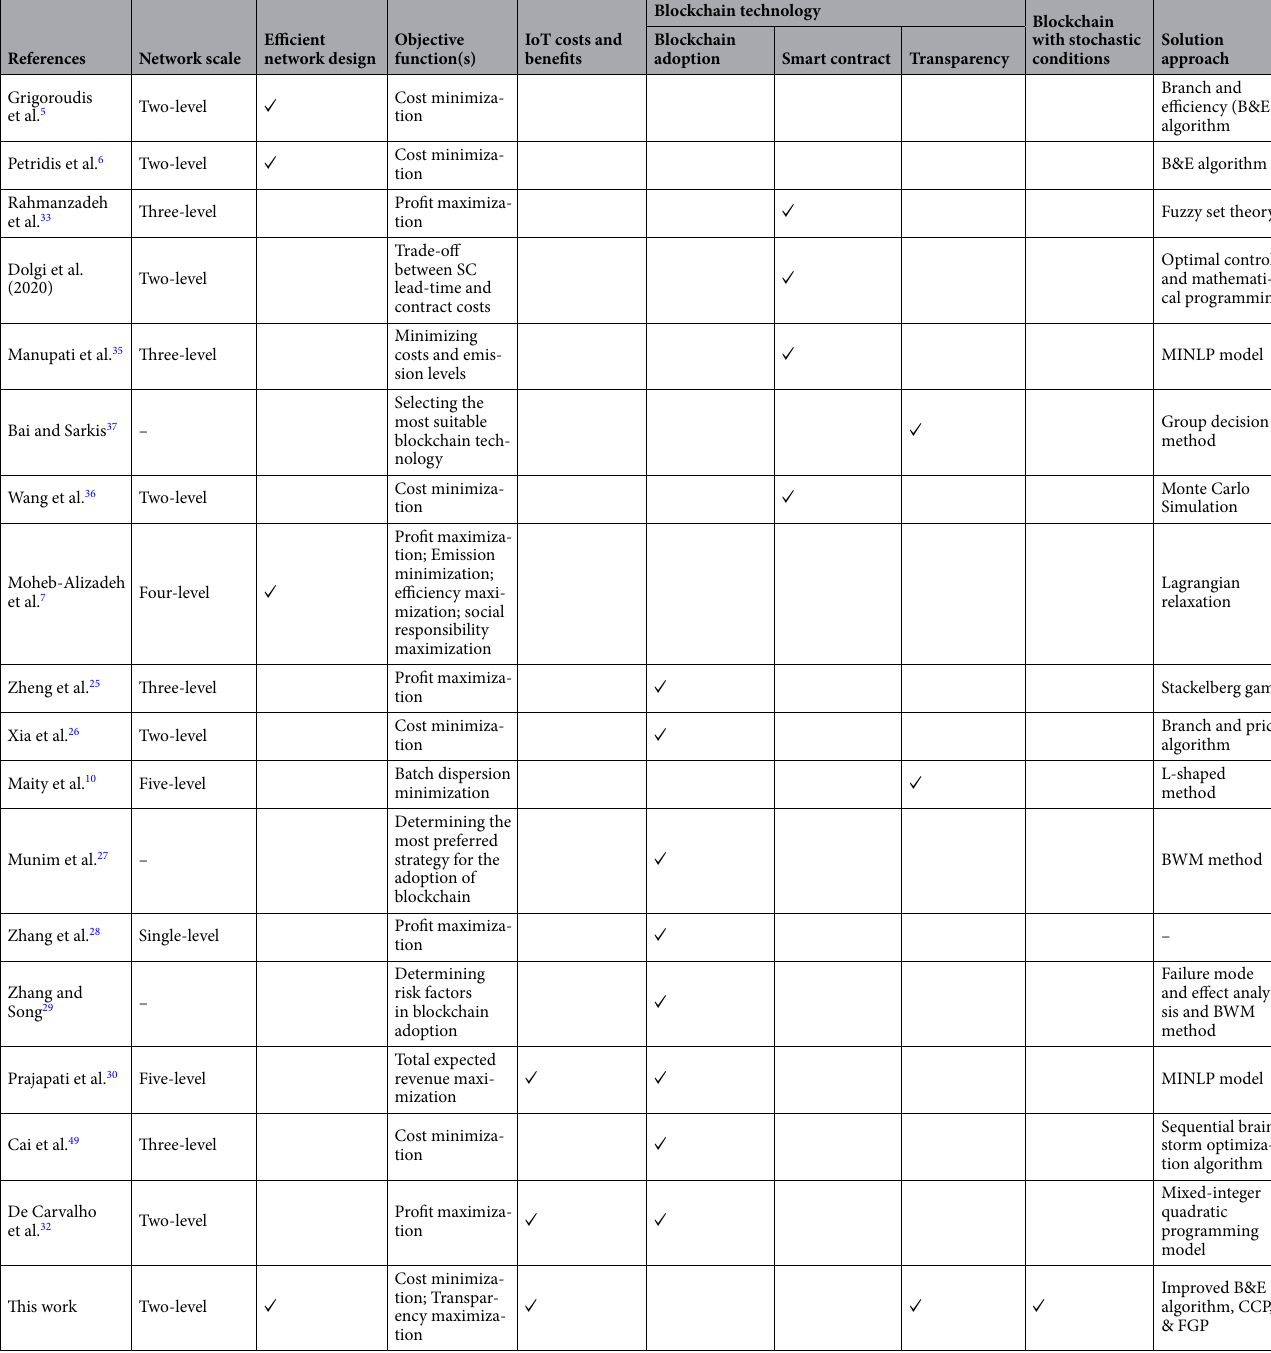
Table 1. Comparative analysis of the relevant